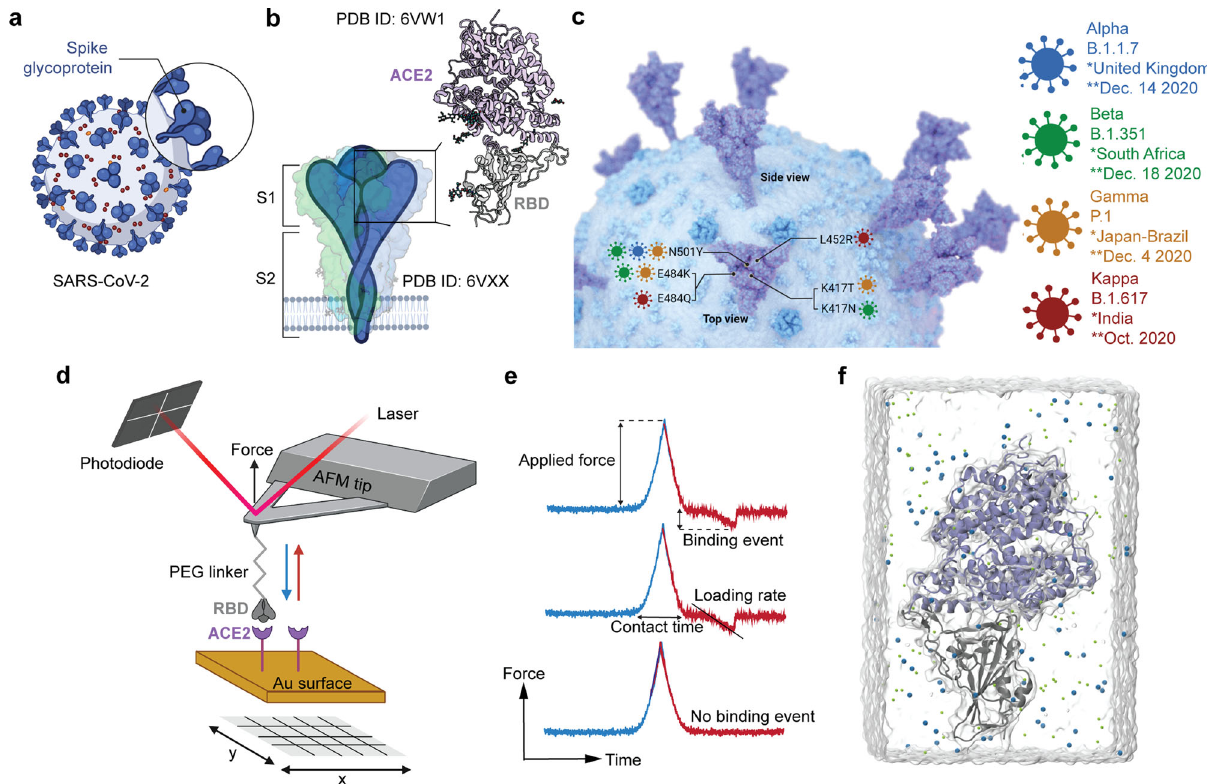
Fig. 1 SARS-CoV-2 mutant binding to ACE host receptor quanti fi ed by atomic force microscopy and molecular dynamics simulation. a Schematic of a SARS-CoV-2 virus particle, expressing at its surface the spike glycoprotein (S) that mediates the binding to host cells. b The S glycoprotein is composed of two subunits, S1 and S2, and is commonly represented as a sword-like spike. The Protein Data Bank (PDB) model of this glycoprotein (ID: 6VXX) reveals how the subunits are comprised of different regions that are fundamental to the infection process. Other Structural studies (PDB ID: 6VW1) have previously obtained a complex between the receptor-binding domain (RBD, a subunit of the S glycoprotein) and the angiotensin-converting enzyme 2 (ACE2) receptor. c Featuring a 3D rendering of SARS-CoV-2, this panel showcases the key spike protein mutations in the RBD domain on each of the studied SARS-CoV-2 variants of concern: Alpha, Beta, Gamma, and Kappa. d Schematic of probing RBD mutant binding to ACE2 receptors using atomic force microscopy (AFM). RBD is covalently attached to the AFM tip via a heterobifunctional PEG-linker and their binding to ACE2 receptors immobilized on a gold (Au) coated surface is probed. Pixel-for-pixel force distance (FD) curve-based AFM approaches and retracts the tip of an AFM cantilever from the sample to record interaction forces, F , over the tip-sample distance in FD curves. e Force − time curve from which the loading rate (LR) can be extracted from the slope of the curve just before bond rupture (LR = Δ F / Δ t ) (upper curve). The contact time refers to the time when the tip and surface are in constant contact (middle curve). The lower curve shows no binding event. The tip approach is highlighted in blue, and tip retraction in red. f Representation of the system used in MD